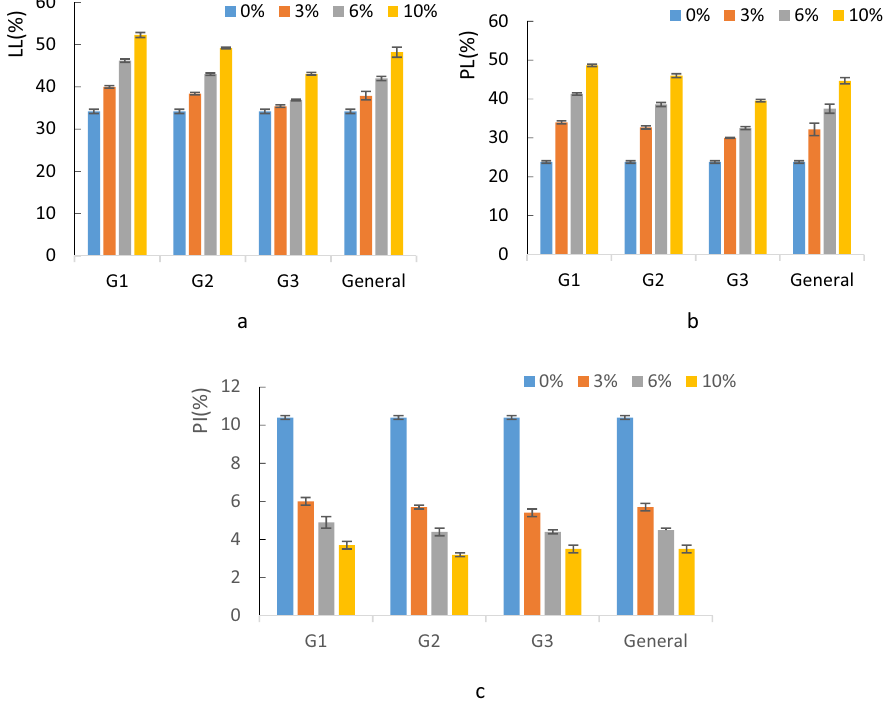
Figure 3: Variation of LL ( a ) , PL ( b ) , and PI ( c ) with particle size and content of nano TiO 2